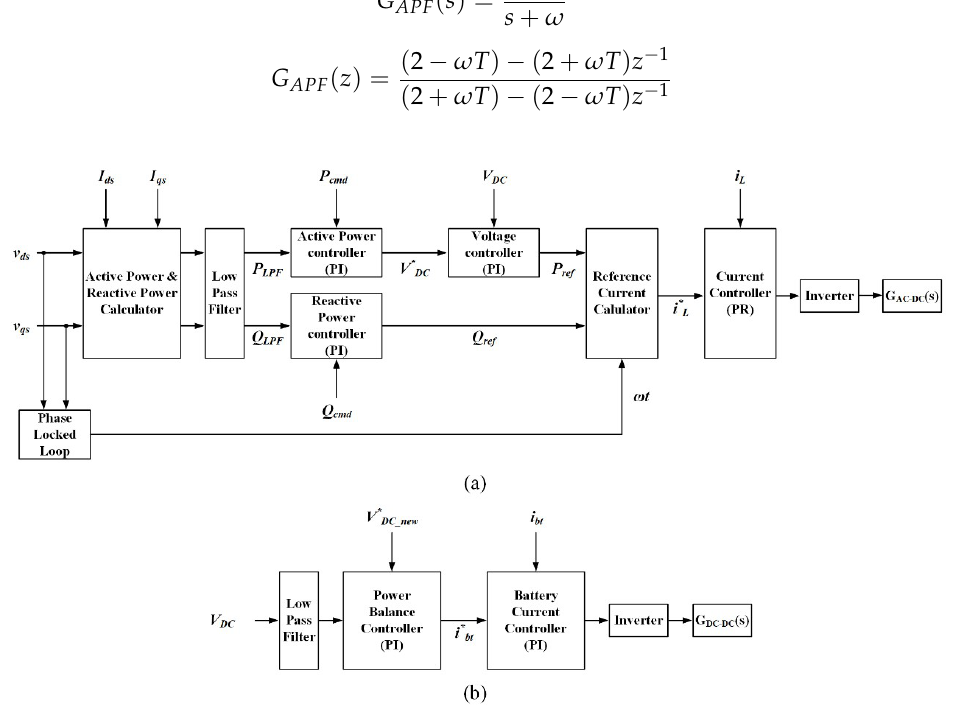
Figure 3. Block diagram of active and reactive power flow control method: ( a ) AC–DC full bridge converter and ( b ) DC–DC converter.